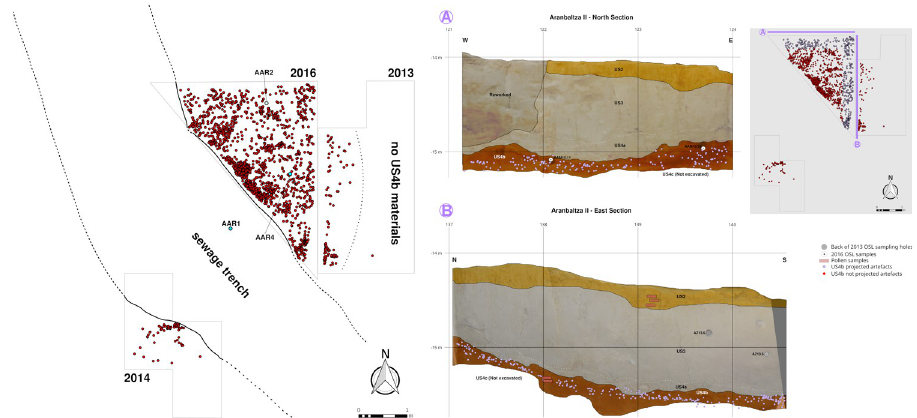
Fig 3. Excavation map and sections. A) Detailed map of the excavated Chaˆtelperronian deposits with the position of the sedimentological cores and the coordinated archaeological remains; B) North and east section of Area 3 excavation with the projected position of the archaeological materials and the positions of the pollen samples and the dated OSL samples.